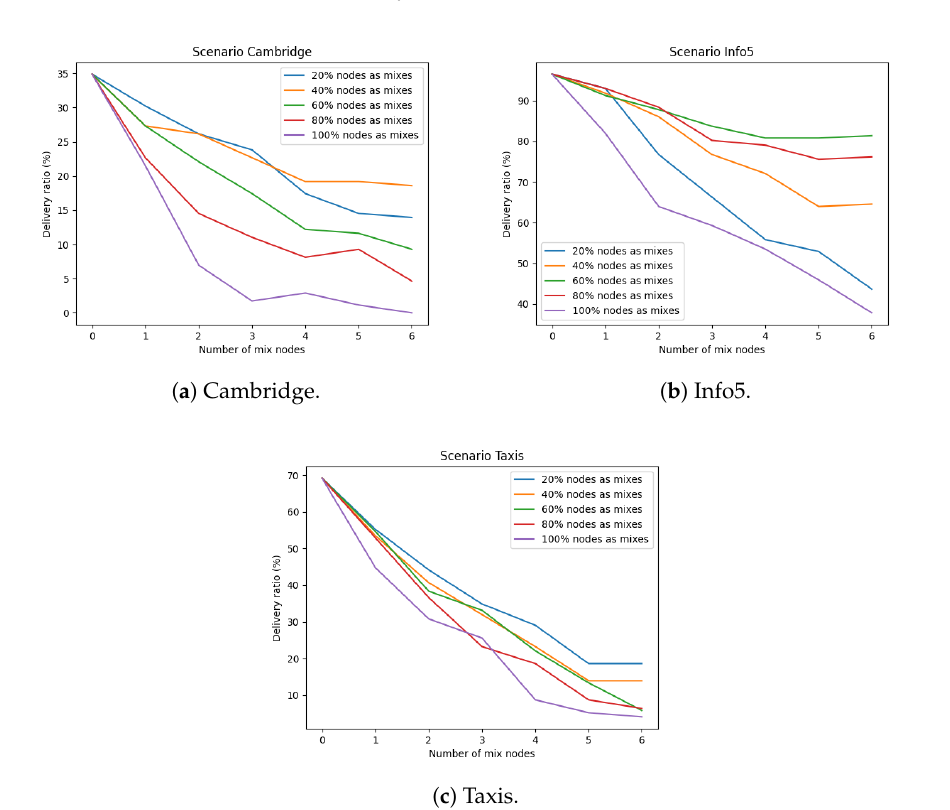
Figure 2. Delivery ration with random mix nodes.